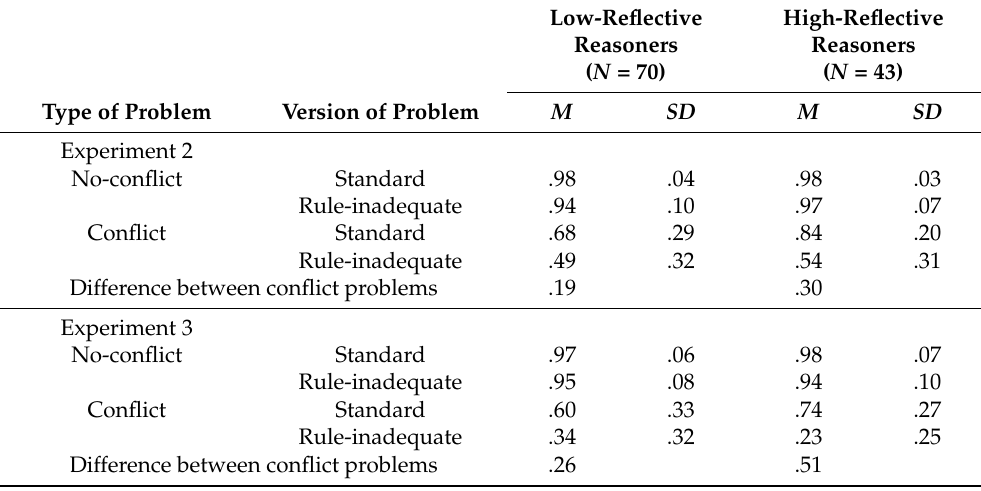
Table 4. Means and standard deviations of base-rate responses for different types and versions of problems for low- and high-reflective reasoners in Experiments 2 and